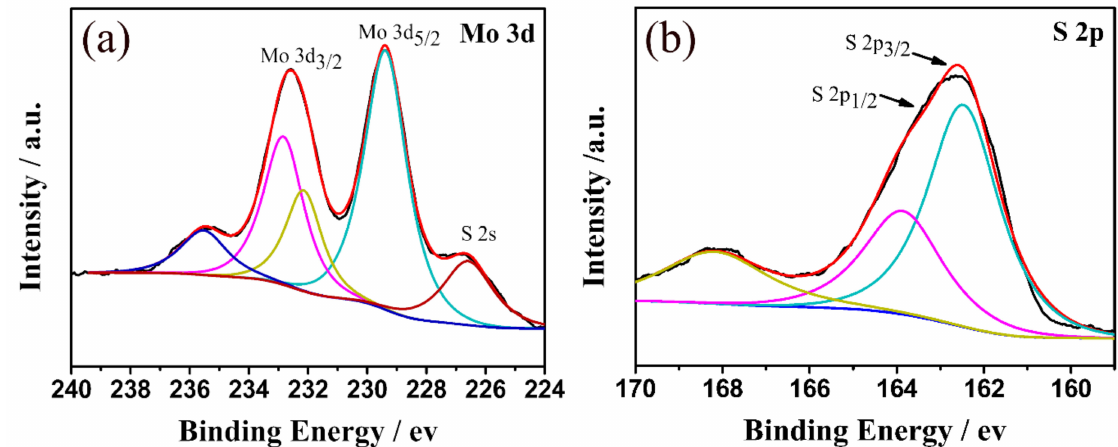
Figure 5. ( a ) Mo 3d spectra and ( b ) S 2p X-ray photoelectron spectroscopy (XPS) spectra of the MoS 2 /C-2